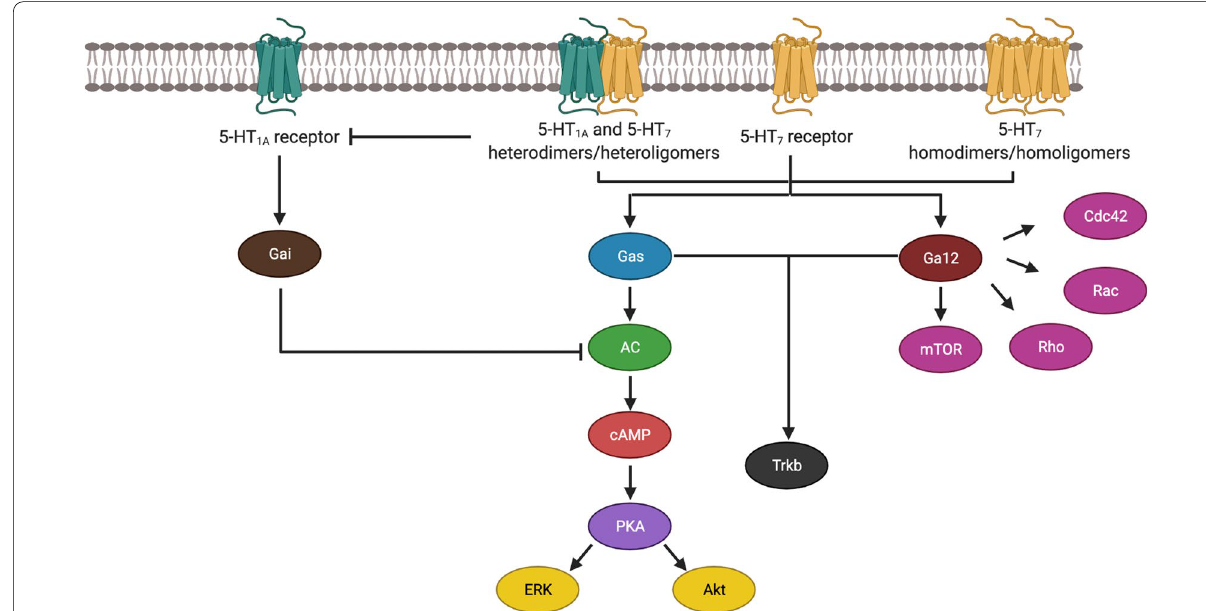
Fig. 1 5‑HT 7 and 5‑HT 1A receptor signaling pathways and oligo/heterodimer formation. 5‑HT 7 receptor monomers (in yellow) can form homodimers or homoligomers, with the same signaling pathways and cellular effects. 5‑HT 7 can also form heterodimers or heteroligomers